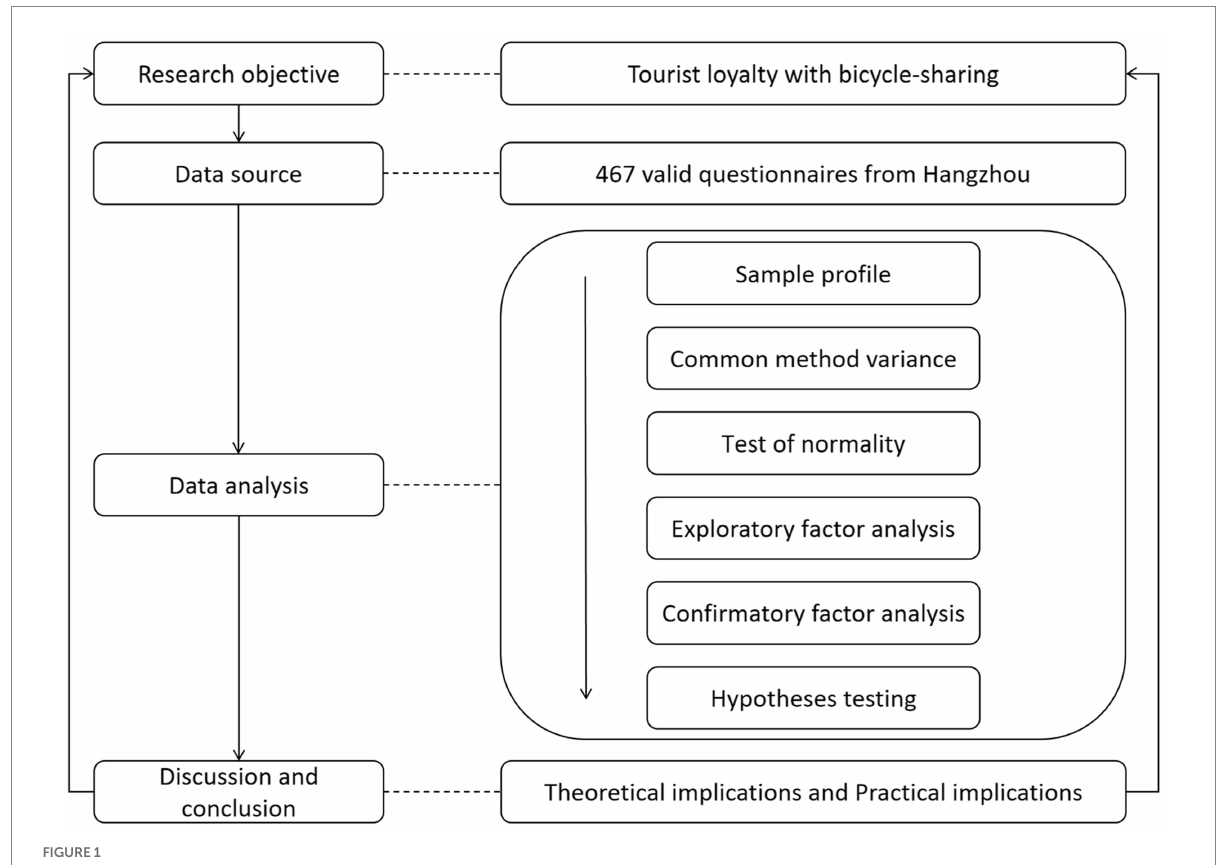
FIGURE 1 Road map of the